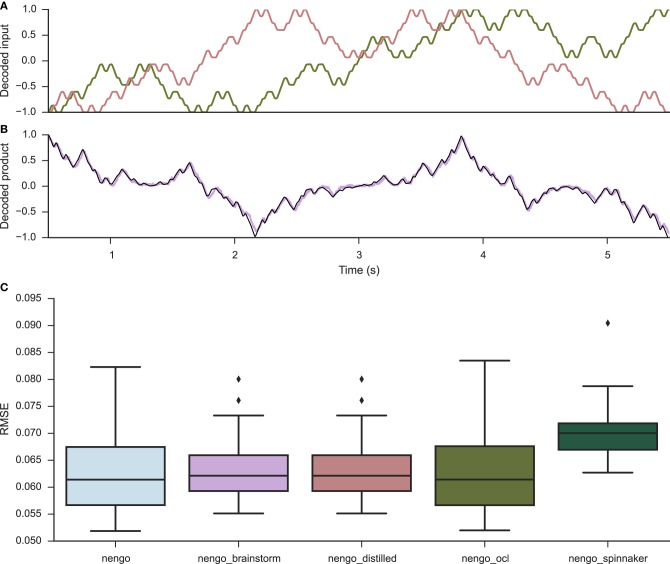
Two-dimensional product model. (A) One example instance of the model run on the reference backend; the decoded input represented by the two-dimensional ensemble is shown. The input signal is designed to fully explore the two-dimensional vector space in the range [−1, 1]. (B) The decoded product represented by an ensemble downstream of the ensemble representing the input. It closely matches the correct product (indicated with the solid black line). (C) The aggregated accuracy results for 50 trials of each backend on the two-dimensional product model. The measured metric is the root mean-squared error (RMSE) between the decoded output of the ensemble representing the product and the correct product, during the whole range of inputs provided over 5 simulated seconds (after a 500 ms wait period to allow the input ensemble to reach the correct initial state). The box shows the median and interquartile range, while the whiskers extend to the farthest data point within 1.5 times the interquartile range; outliers are shown above and below the whiskers.